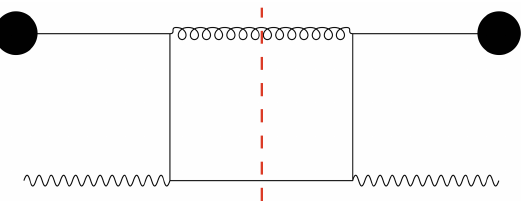
Figure 1: Depicted we see the one loop DIS hadronic tensor, with p and q the mo- menta of the hadron and photon. The black dots are the hadrons and the red line is a